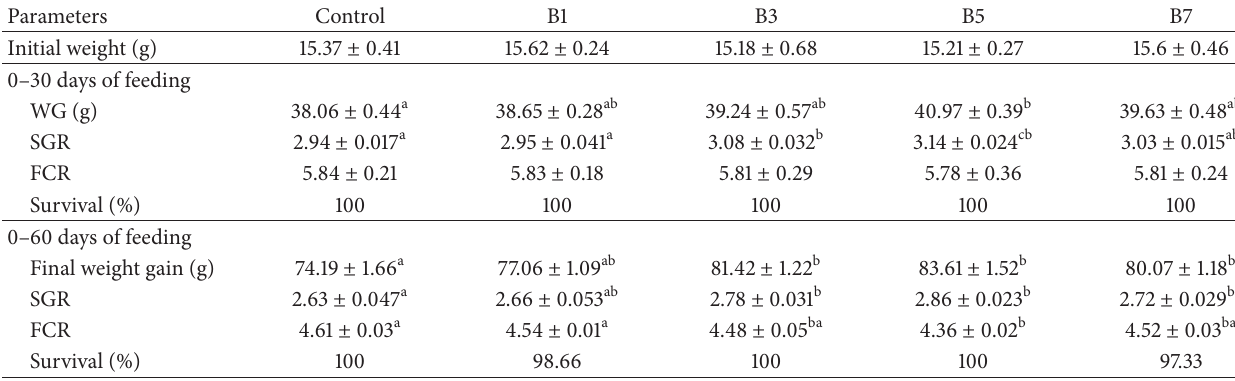
Table 3: Effects of banana peel flour (BPF) on the growth performance of Labeo rohita .